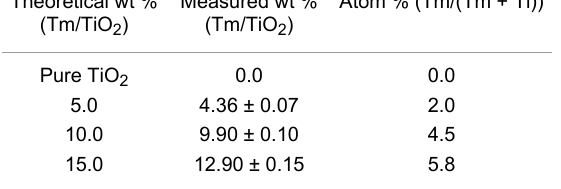
Table 1: Experimental weight percentage obtained by ICP–AES and atomic/molar percentage compared to the theoretical, stoichiometric weight